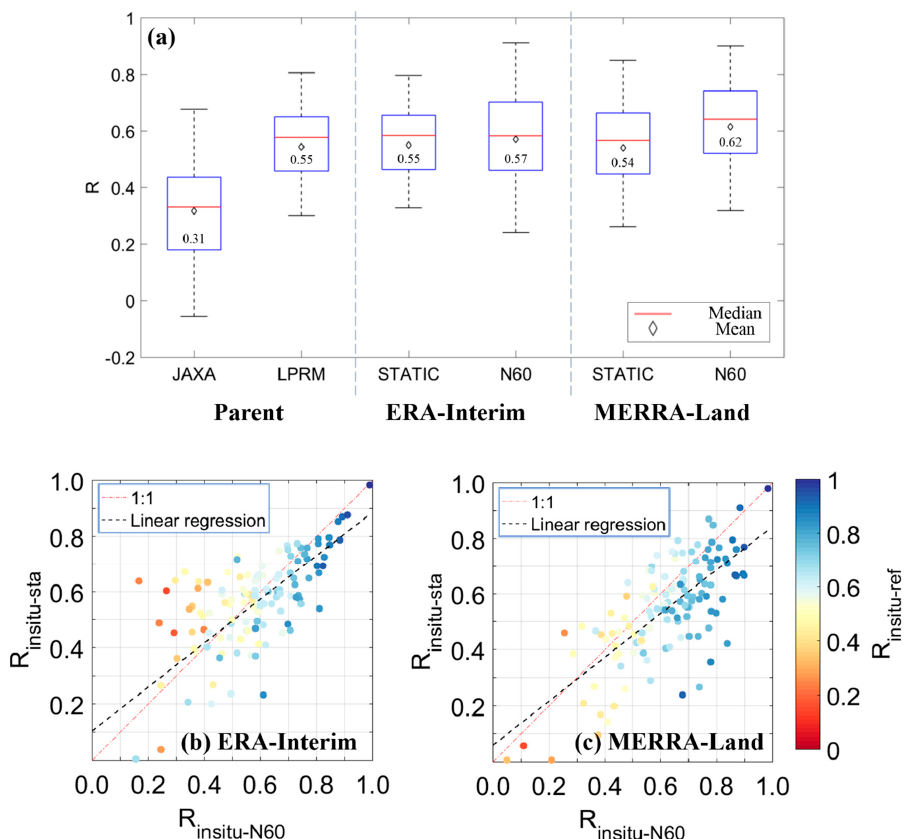
Figure 6. ( a ) Box plots showing combination performances against in situ measurements with the N60 and the two references. The labels on the x-axis indicate parent or statically-/dynamically-combined products with the references, and the y-axis R between the product and the in situ measurements. The value in each box is the mean of R. Comparison against in situ measurements from the ISMN for dynamically combined products using the N60 and ( b ) ERA-Interim and ( c ) MERRA-Land as the reference, respectively. The x-axis presents R between a dynamic product and the in situ measurements from a station, the y-axis R between a static product and the in situ measurements. Data points in Figure 6 that are below the 1:1 line represent locations where the dynamic approach is better than the static one. The overall relation between these approaches over all sites in the ISMN is represented by the linear regression lines. Those regression lines show that the performance of the dynamic combination is generally better than the static approach, particularly when the initial R between the ISMN dataset and the reference data is high R > 0.4. An interesting